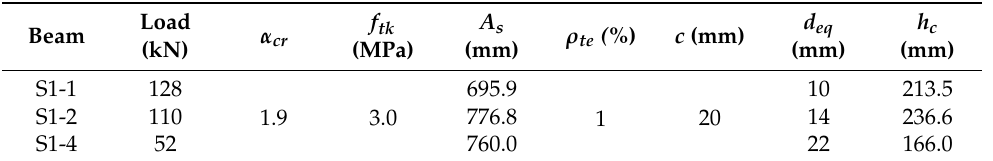
Table 9. Variables involved in computation.